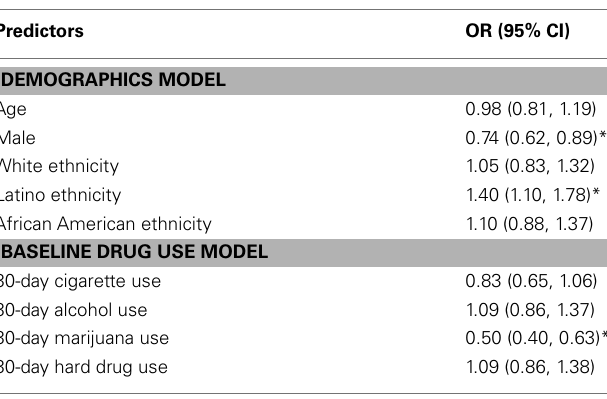
Table 1 | Baseline demographics and drug use predicting marijuana cessation at the 1-year follow-up.